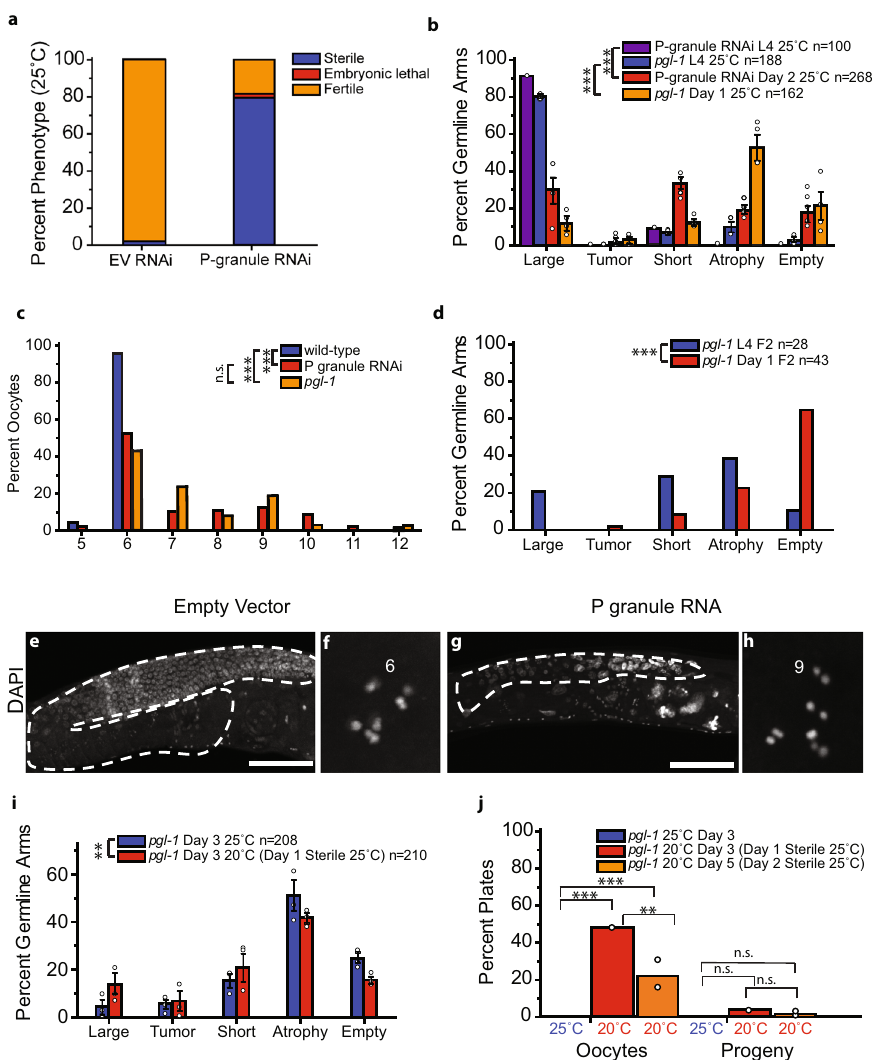
Fig. 4 Disruption of P granules by RNAi or by de fi ciency for pgl-1 results in similar phenotypes. a F2 wild-type (N2) worms on Empty Vector (EV) or P granule RNAi at 25 °C were scored for sterility, embryonic lethality, or fertility; n = 16 – 30 worms per condition, two independent experiments. b Germline phenotypes of 25 °C exposed F1 L4 pgl-1 mutants and F2 L4 P granule RNAi-treated animals stained by DAPI. c F1 pgl-1 mutants and F2 P granule RNAi- treated animals contained oocytes with increased numbers of univalents at sterility as measured by DAPI bodies, n = 151 wild type, 81 P granule RNAi, 37 pgl-1 . Signi fi cance was determined between wild-type, P granule RNAi, and pgl-1 datasets. d Stained DAPI germlines of sterile F2 L4 and day 1 pgl-1 mutants. Signi fi cance was determined between pgl-1 L4 and day 1 datasets. e – h Representative DAPI images of germline and oocyte defects in empty-vector-treated animals ( e , f ) and P granule RNAi-treated animals ( g , h ), scale bar = 100 µ m. P granule RNAi-treated animals have a smaller germline than on control empty vector RNAi. At least four independent imaging experiments were performed and representative images are shown. While empty vector RNAi wild- type oocytes contain six univalents, oocytes following P granule RNAi treatment often have more than six univalents. i pgl-1 F1 worms at 25 °C were either DAPI stained as day 3 adults (blue) or shifted to 20 °C on day 1 and DAPI stained at day 3 (red). j No sterile day 1 pgl-1 F1 at 25 °C laid oocytes or progeny ( n = 35 plates, 350 worms). Sterile F1 day 1 pgl-1 shifted to 20 °C ( n = 50 plates, 500 worms) and day 2 pgl-1 shifted to 20 °C ( n = 121 plates, 121 worms) gave rise to plates with oocytes and rarely progeny. Plates with oocytes contained both oocytes and dead embryos. Plates with progeny contained embryos that hatched to L1. For b , d , i , *** p < 0.0001, ** p = 0.007 two-tailed Fisher ’ s Chi Square test with Bonferroni correction, n = total germline arms scored, for c and j *** p < 0.0001, * p < 0.01, n. s. = p > 0.05 two-tailed Fisher ’ s exact test for count data with Bonferroni correction, error bars are